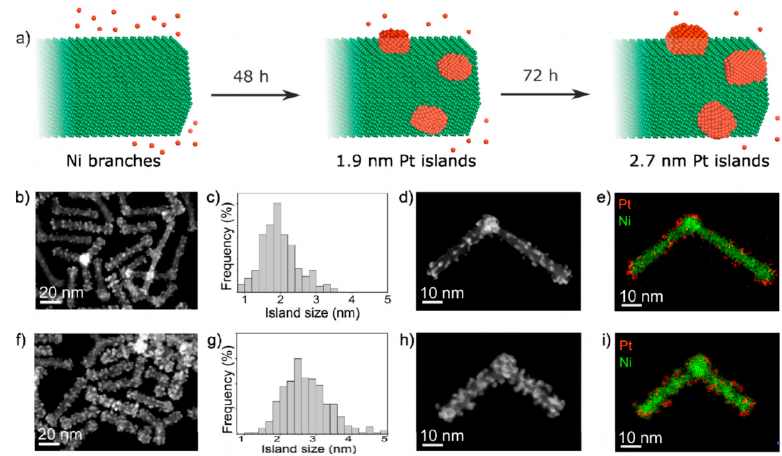
Figure 4. ( a ) Scheme illustrating the growth of Pt atoms (red) directly on a Ni branch (green). ( b ) TEM image of the Ni-branched Pt-islands nanoparticles after 48 h (1.9 nm Pt-island). ( c ) Pt island size distribution. ( d ) HAADF-STEM image of a Ni-branched 1.9 Pt-island nanoparticle. ( e ) STEM-EDX map showing Pt (red) islands on Ni (green) nanoparticle. ( f ) TEM image and ( g ) Pt island size distribution after 72 h (Ni-branched 2.7 nm Pt-island). ( h ) HAADF-STEM image of a Ni-branched 2.7 nm Pt-island. ( i ) STEM-EDX map with Pt (red) and Ni (green). Reprinted (adapted) with permission from [68]. Copyright (2019) American Chemical